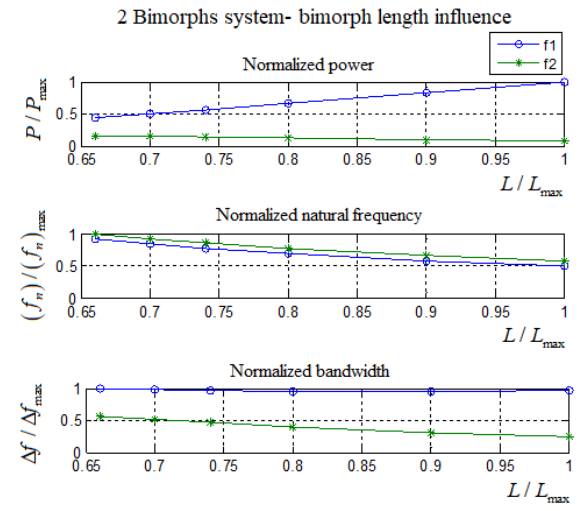
Figure A6. The influence of the normalized bimorph length on the output harvested power, natural frequency, and bandwidth (all normalized)—two bimorphs interconnected by a spring case.